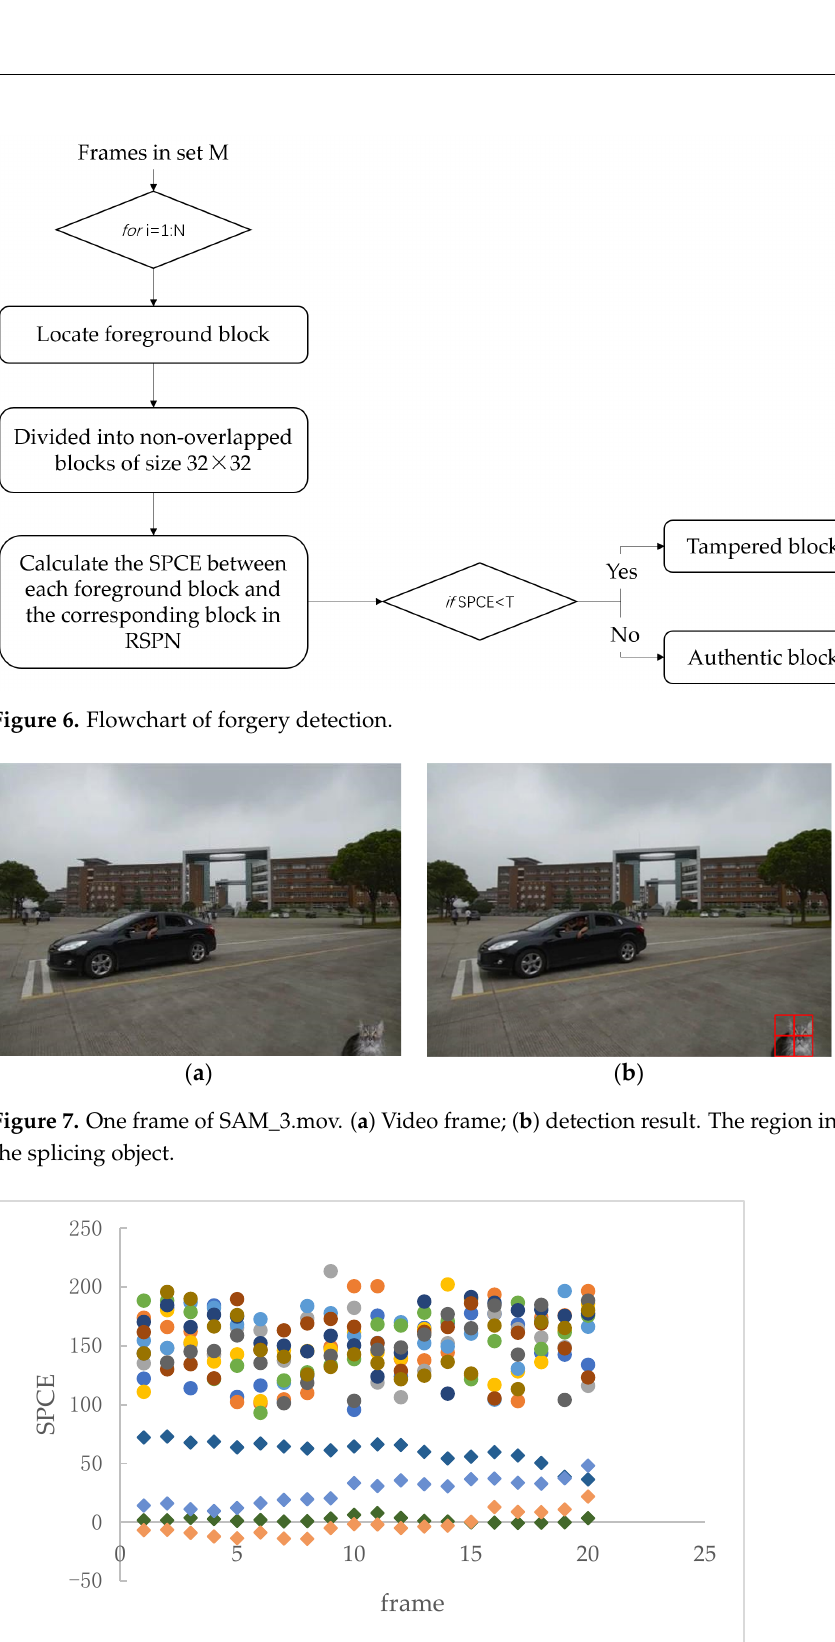
Figure 7. One frame of SAM_3.mov. ( a ) Video frame; ( b ) detection result. The region in the red box is the splicing object.